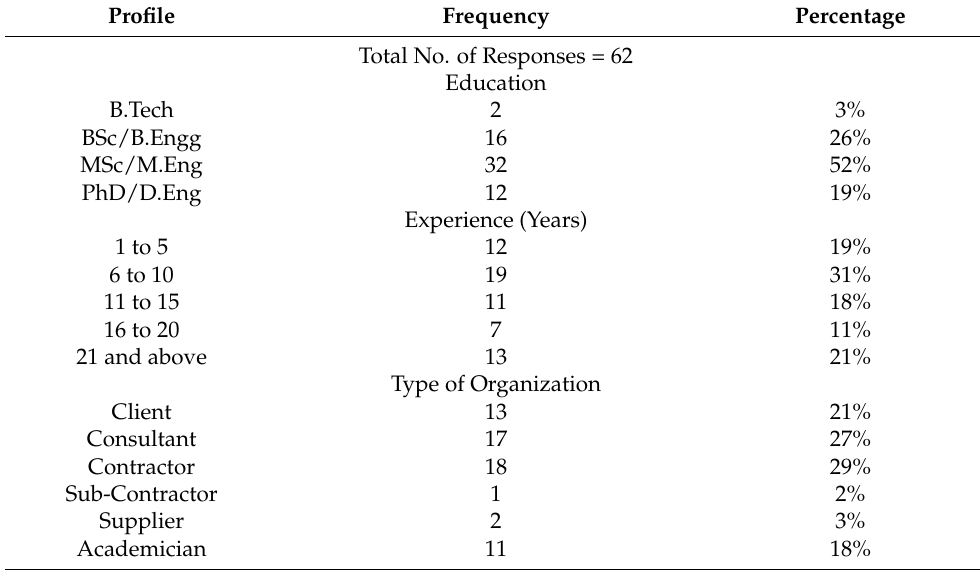
Table 6. Frequency distribution of